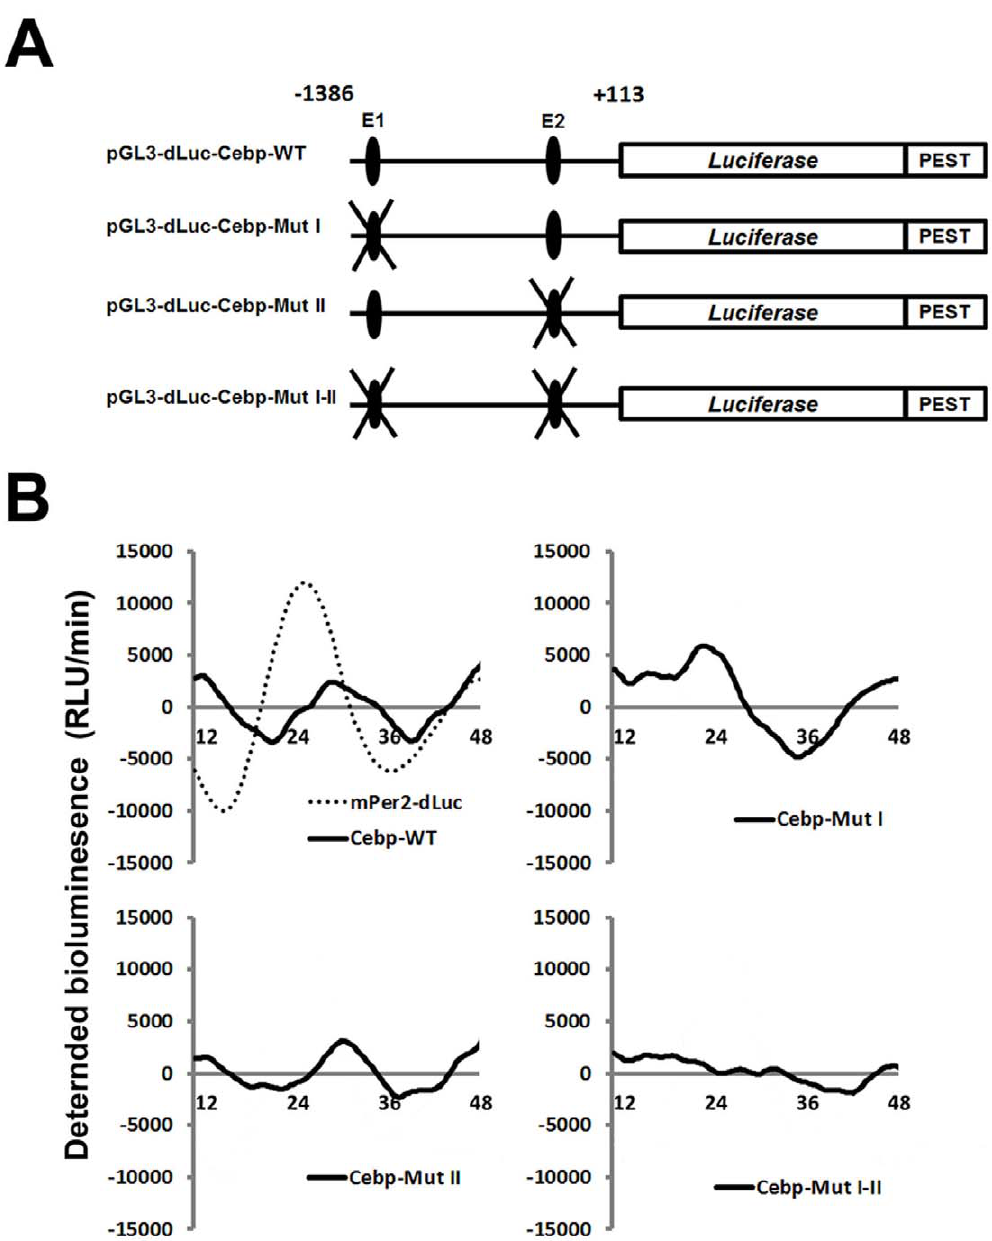
Figure 3. E1 and E2 sites contribute to circadian expression of C/ebp a . (A) Schematic representation of mutant constructs of C/ebp a promoter region. Either or both E-boxes (sites E1 and E2) were mutated (E1, 5 9 -CACGTG-3 9 to 5 9 -CACCAC-3 9 ; E2, 5 9 -CACGTG-3 9 to 5 9 -CACCAC-3 9 ). (B) Real time reporter assay. NIH3T3 cells transfected with indicated mutant constructs were incubated with dexamethasone (100 nM) and then bioluminescence was measured. Plasmid pGL3-dLuc-Cebp-WT , wild type 1.4 kb upstream region of C/ebp a gene;, pGL3-dLuc-Cebp-Mut I , mutant E1 site; pGL3-dLuc-Cebp-Mut II , mutant E2 site; pGL3-dLuc-Cebp-Mut I-II , mutant E1 and E2 sites; mPer2-dLuc , Per2 promoter region ( 2 798 to + 331 relative to the cap site) cloned into pGL3-dLuc [23]. Each experiment was repeated 3-5 times and representative data were used for these